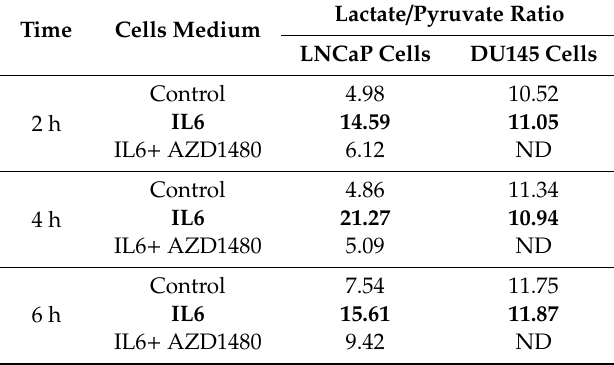
Table 2. E ff ect of IL-6 stimulation, in presence or absence of AZD1480, on the lactate / pyruvate ratio in Table 2. Effect of IL-6 stimulation, in presence or absence of AZD1480, on the lactate/pyruvate ratio the medium of LNCaP and DU145 in the medium of LNCaP and DU145 cells.